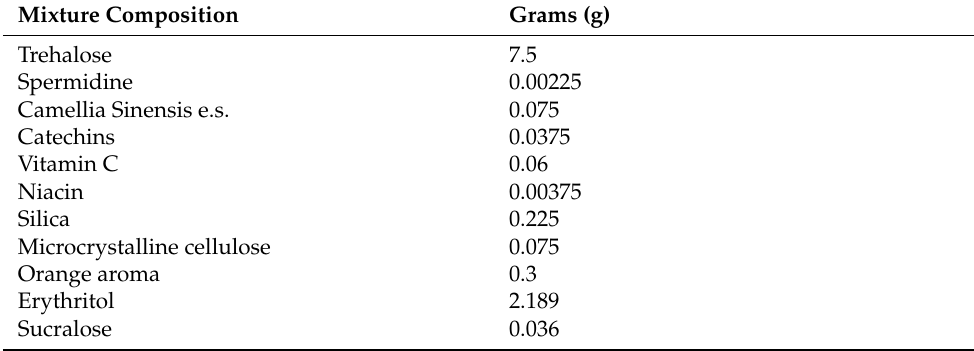
Table 1. Mixture